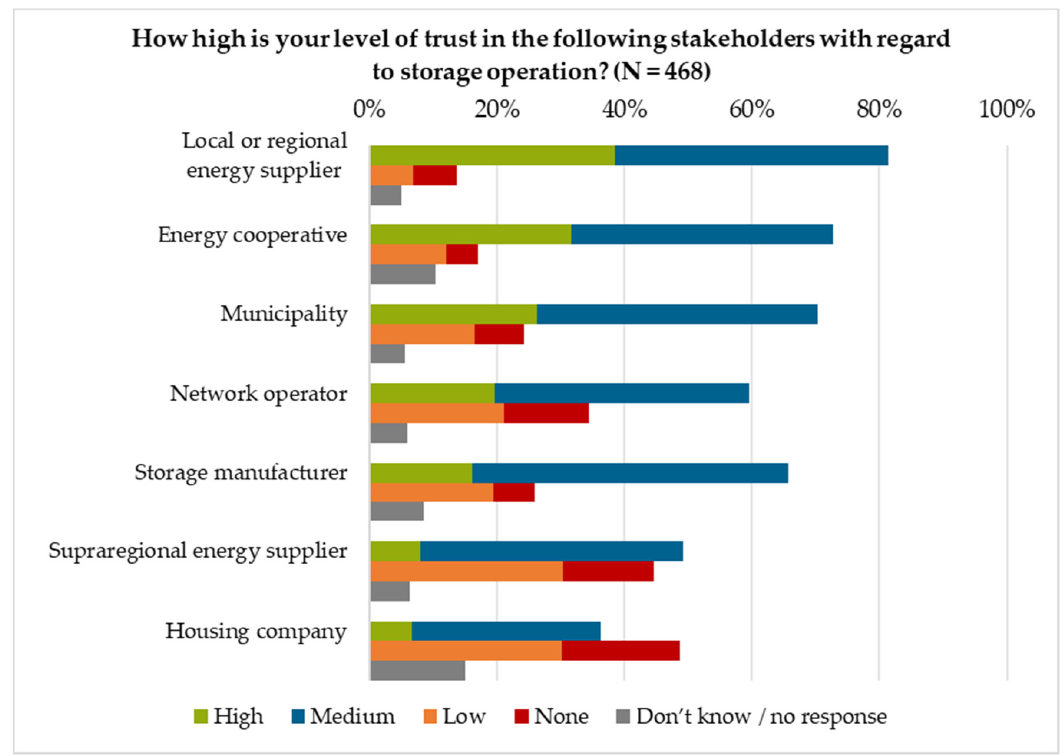
Figure 5. Trust in potential operators of an energy storage system.